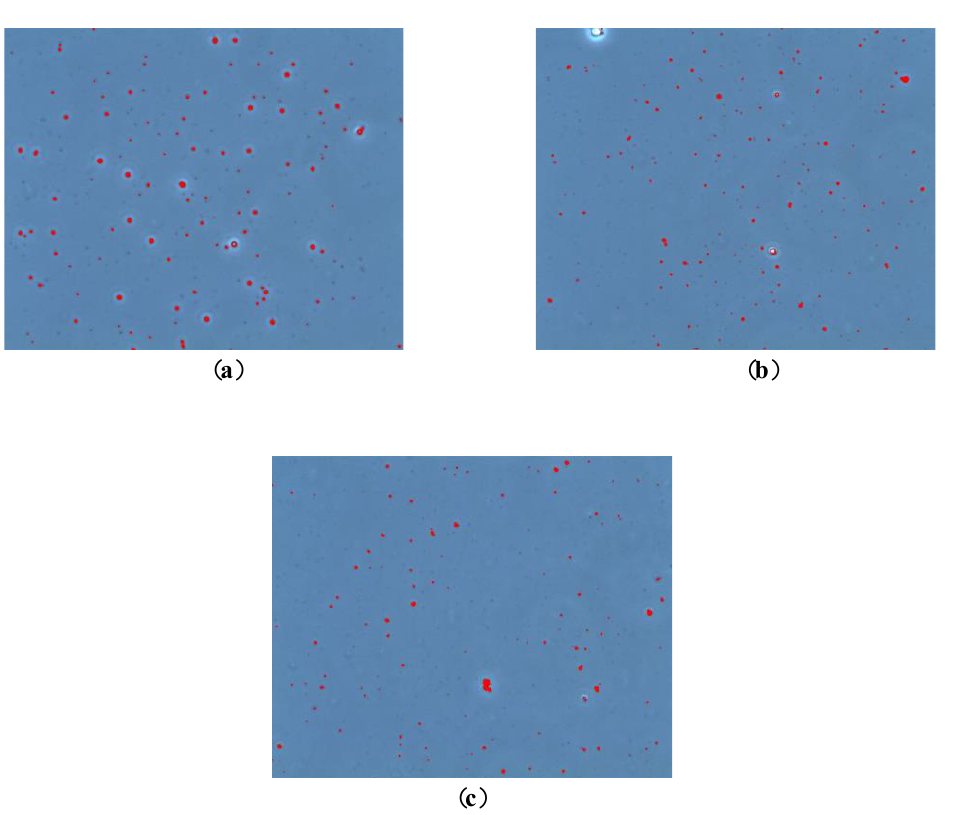
Figure A2. Image examples of emulsions in distillate water ( a ) sample after 1 h, ( b ) sample after 3.5 h, ( c ) sample after experiment at 48 h.